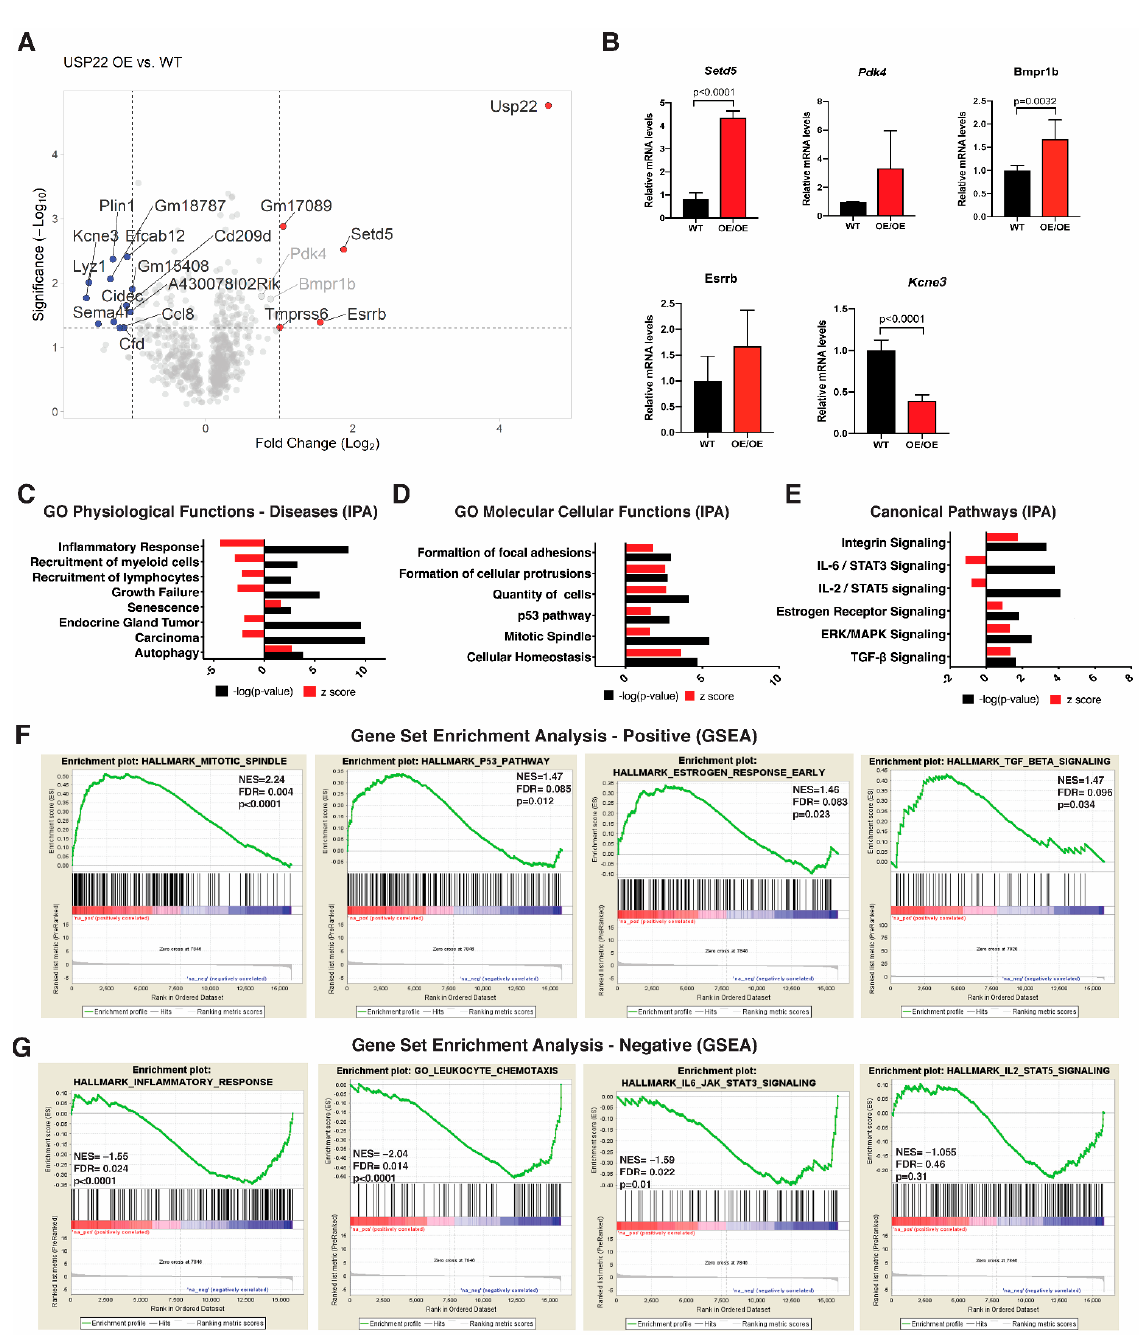
Figure 3. Altered gene expression profiles in Usp22 overexpression primary mammary epithelial cells identify deregulated signaling cascades. ( A ) Volcano plot representation of differential expression analysis of genes upon Usp22